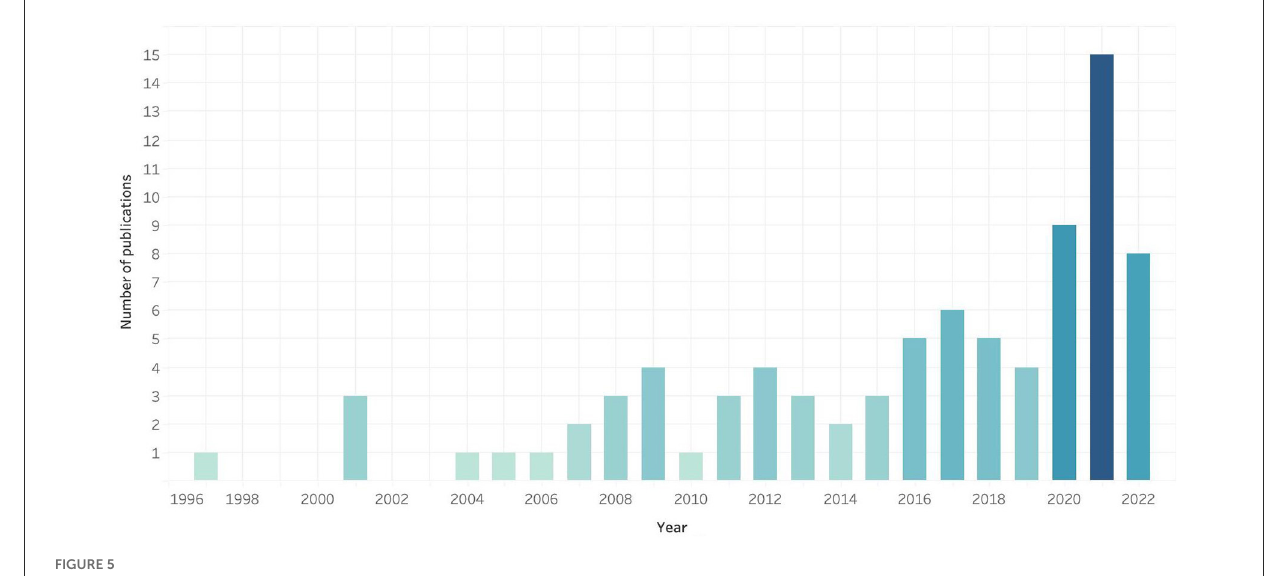
FIGURE5 Number of publications related to PBI per year.